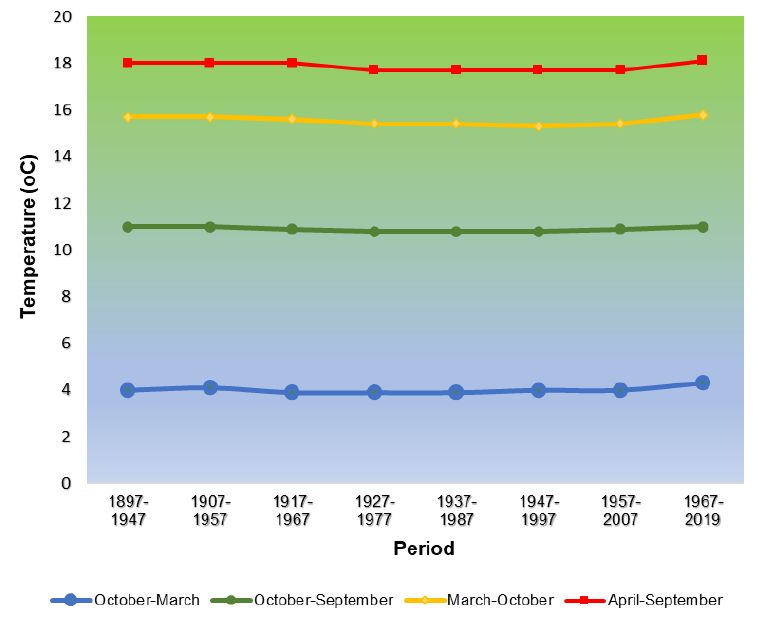
Figure 6. Temperature evolution of 1897-2019 represented over periods of 50 years.